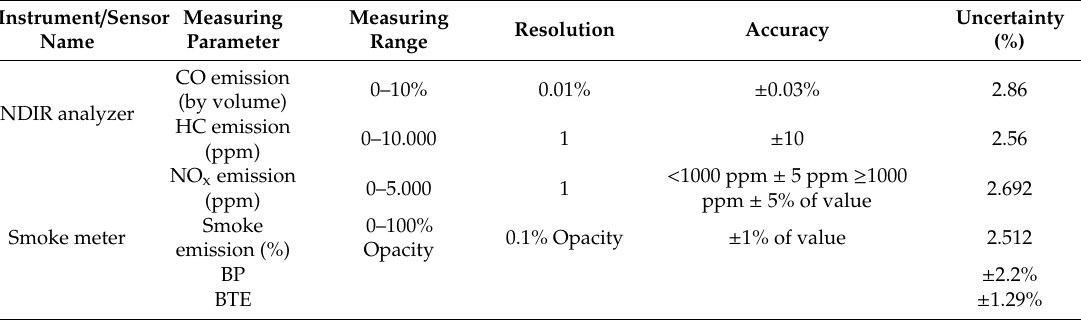
Table 6. Details of measurement range and resolution of